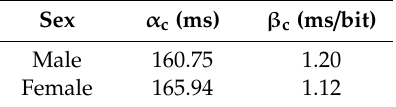
Table 3. Parameters α c and β c values for male and female individuals.